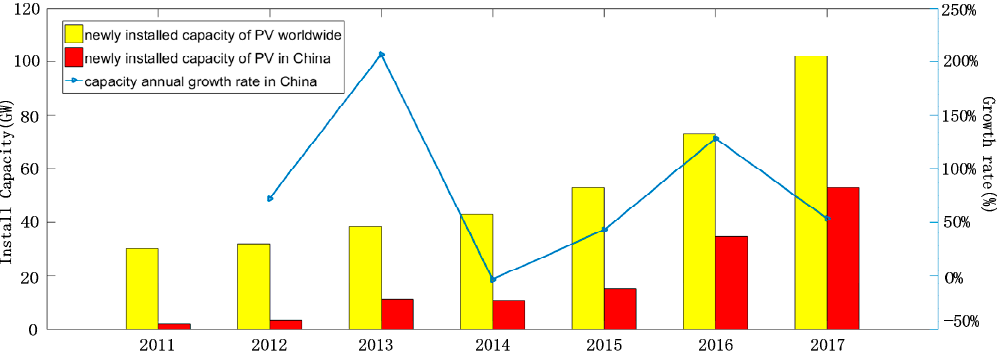
Figure 1. Annual newly installed capacity of PV (2011–2017).